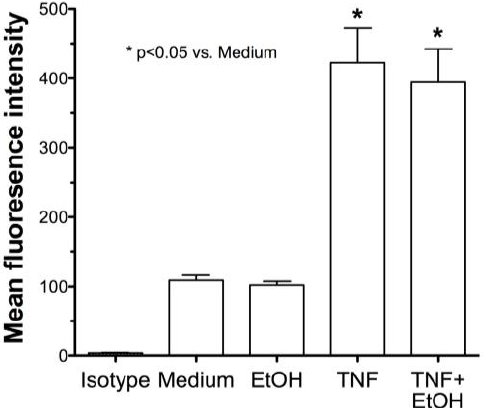
Figure 7. Alcohol does not directly affect TNFα-induced ICAM-1 expression. BEAS-2B were treated with either TNFα (0.1 ng/mL) or TNFα incubated with 100 mM ethanol for 1 h before epithelial cell treatment. FACS for ICAM-1 revealed a significant increase in ICAM-1 expression even when cells were treated with TNFα + ethanol. Bar graphs represent the mean with standard error bars of 3 separate experiments (* p < 0.05 vs. control medium).